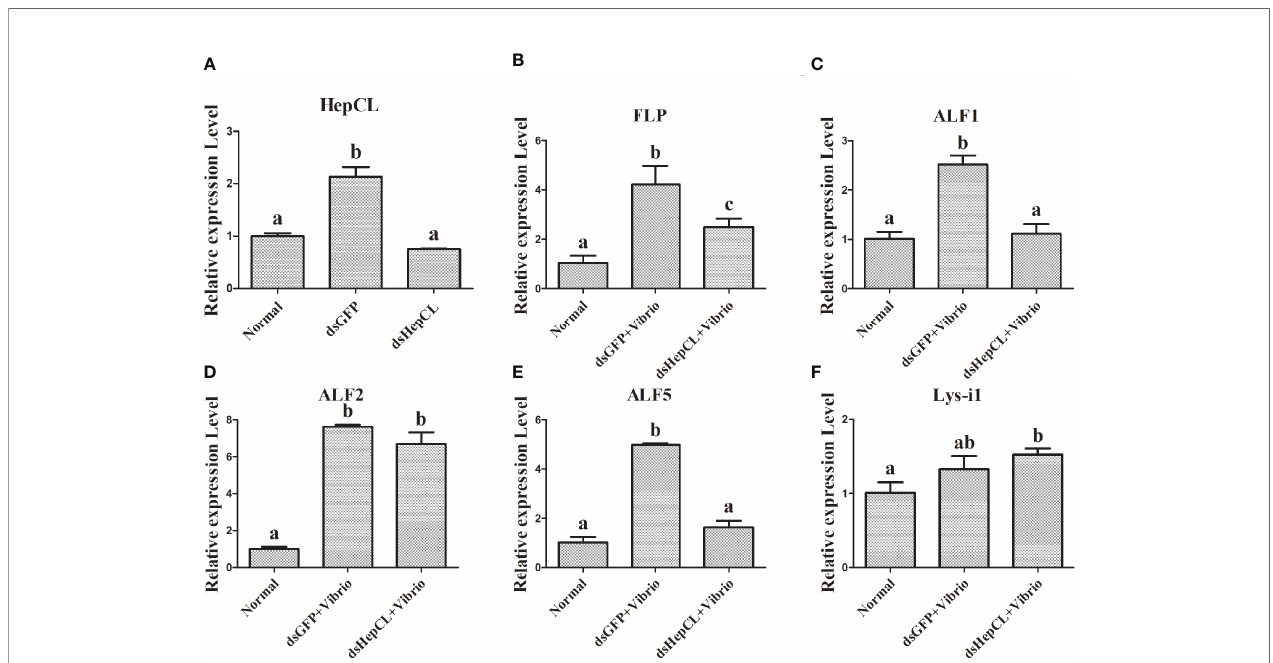
FIGURE 7 | The expression levels of antimicrobial proteins after knockdown of HepCL. (A) qPCR was used to analyzes the effect of HepCL was knockeddown. (B – F) The expression levels of FLP, ALF1, ALF2, ALF5 and Lys-i1 was analyzed under knockdown of HepCL after Vibrio infection by qPCR, dsGFP was used as control. Differences between groups were analyzed using one-way analysis of variance (ANOVA). Different letters indicate signi fi cant differences p < ( Figure 5 ). The bacterial clearance ef fi ciency of the HepCL-N